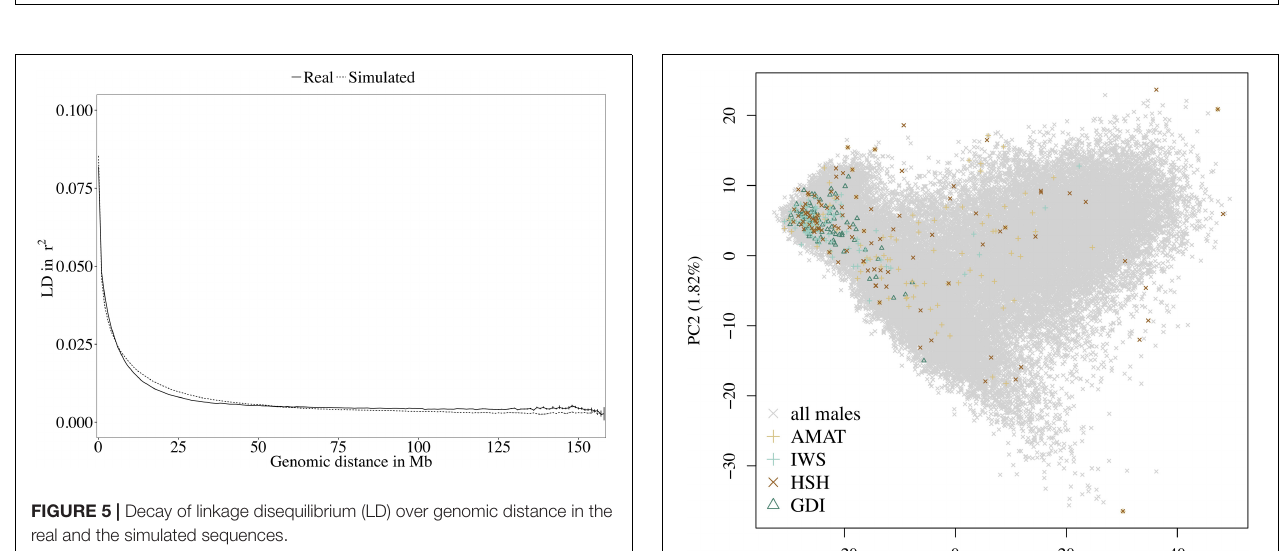
FIGURE 6 | Distribution of the different groups of animals on the first and second principal components. The variance explained by the components is given in brackets. Gray crosses represent all the candidates, the green triangles are the animals selected by the key ancestors (AMAT) method, the purple plusses are the animals selected by the Inverse Weighted Selection (IWS) method, the green plusses are the animals selected by the Highly Segregating Haplotypes selection (HSH) method, and the blue crosses are the animals selected with the Genetic Diversity Index (GDI)